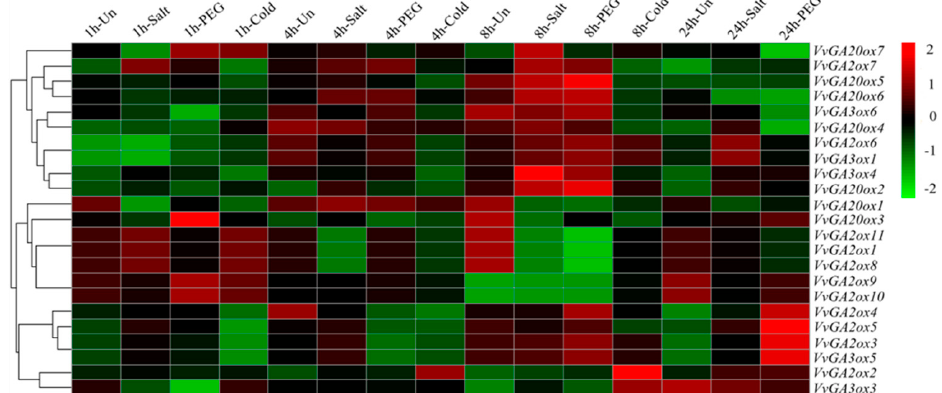
Figure 5. Hierarchical clustering of the expression profiles of 23 VvGAoxs genes at different abiotic stress experiments in grape. Abiotic stress experiments: salt, PEG, and cold. Heatmap experiments were performed with GeneChip microarrays, which were from Affymetrix GeneChip 16K with short-term abiotic stress‘Cabernet Sauvignon.’ Red or green shading represented the upregulated or downregulated expression level, respectively. The scale denoted the relative expression level.